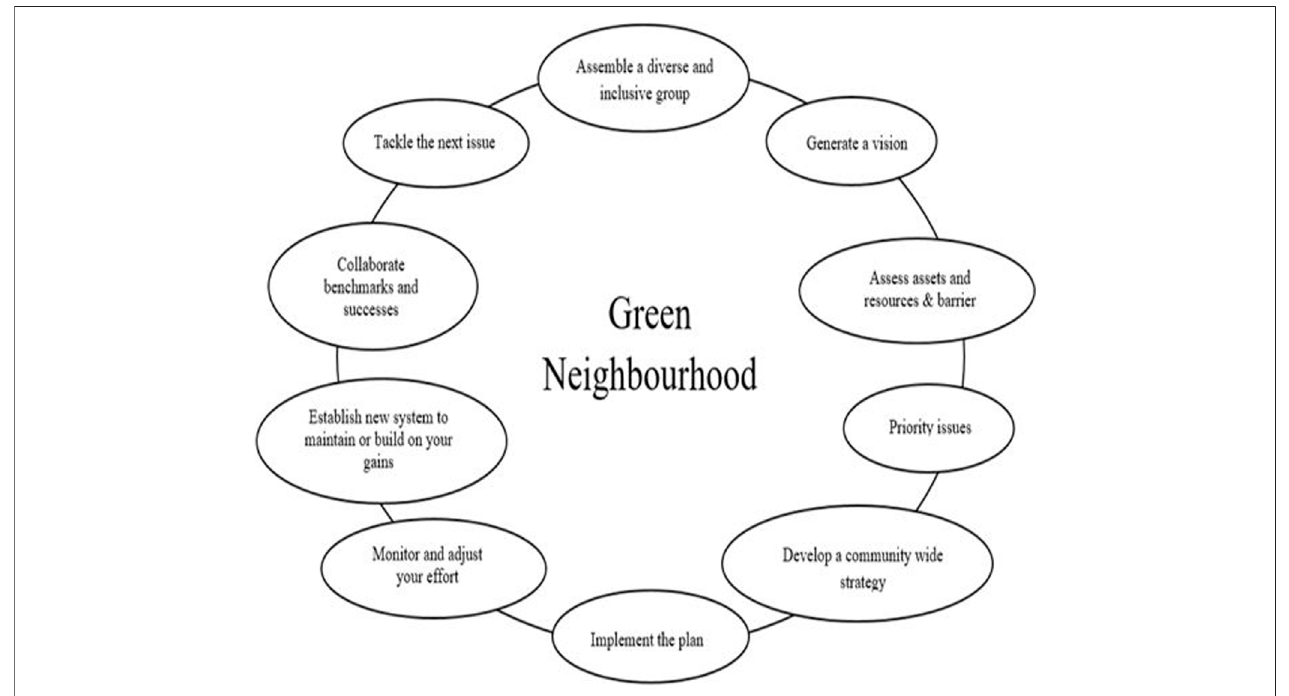
FIGURE 4 | The Components of a Green Neighbourhood; Source: Authors ’ fi eld research, (2021).